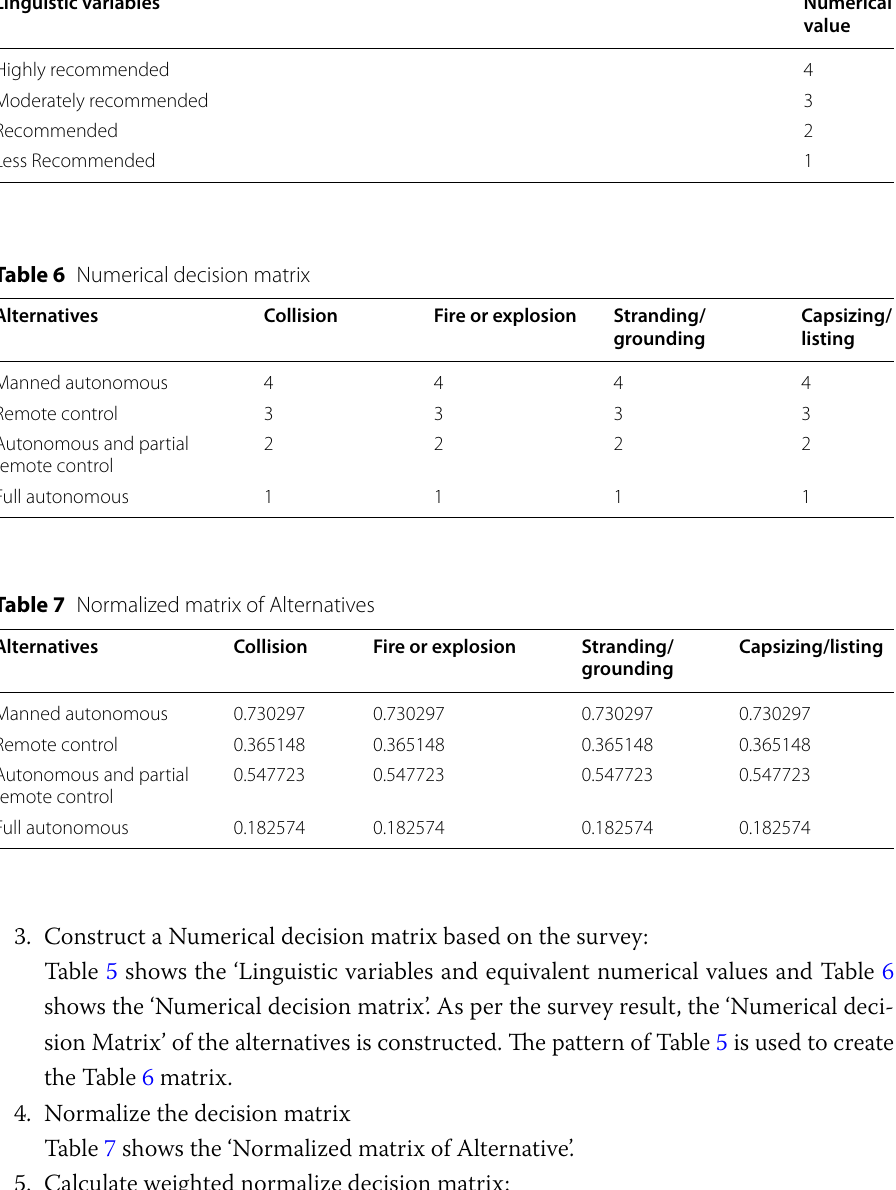
Table 5 Linguistic variables and equivalent numerical values Linguistic variables